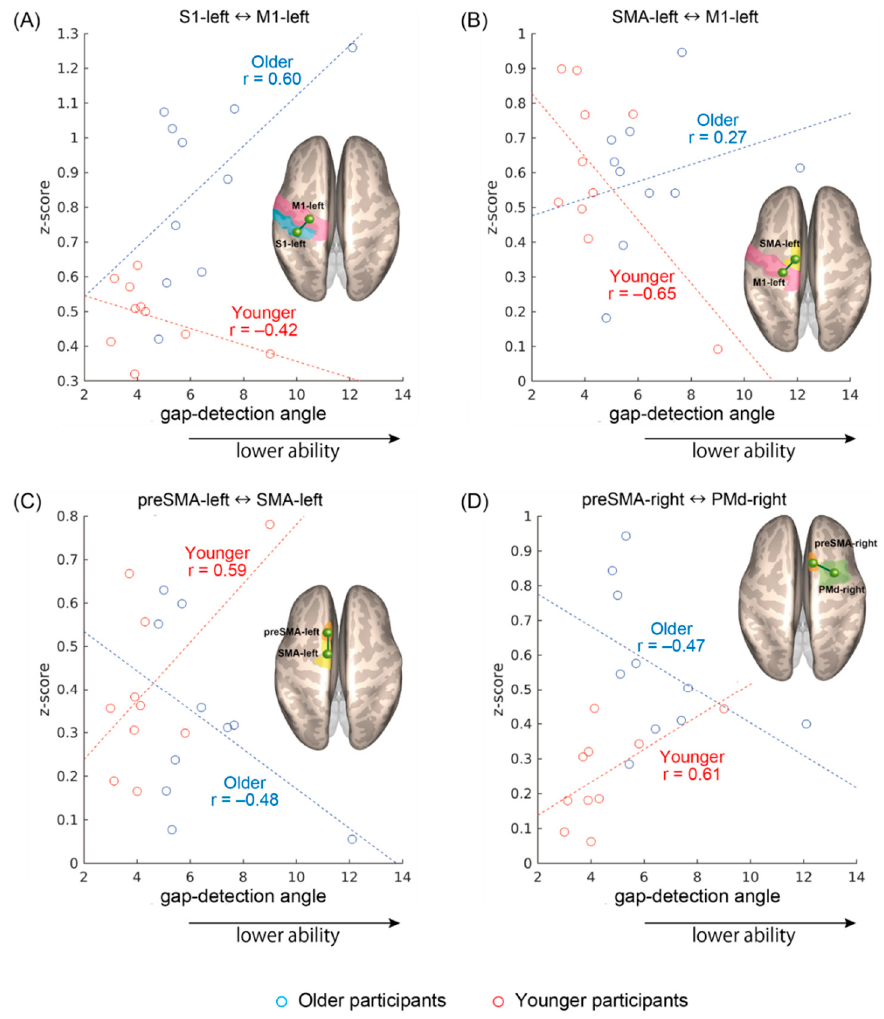
Figure 3. Significant resting-state functional connectivity (rsFC) showing specular interaction effects between age and gap detection ability. ( A ) Connectivity between the left primary sensory area and the left primary motor area (S1left–M1left), ( B ) the left supplementary motor area and the M1left (SMAleft–M1left), ( C ) the left pre-supplementary motor area and the SMAleft (preSMAleft–SMAleft), and ( D ) between the right pre-supplementary motor area and the right premotor area (preSMAright–PMdright). Pearson correlation coefficients are given regardless of the significance of individual regressions.